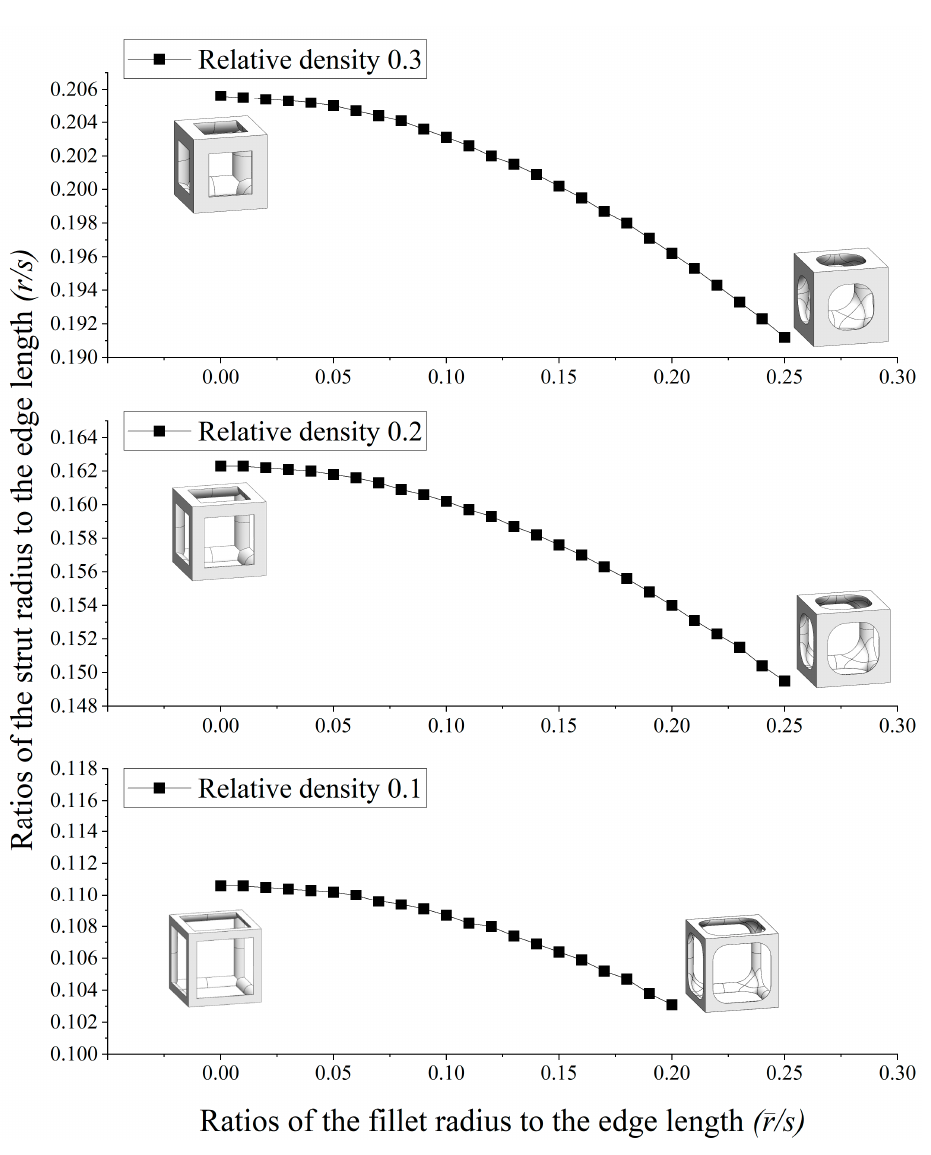
Figure 7. Relationship between the ratio of the strut radius to the edge length and the ratio of the fi llet radius to the edge length at constant relative densities for fi llet edgeless simple cubic unit cells.